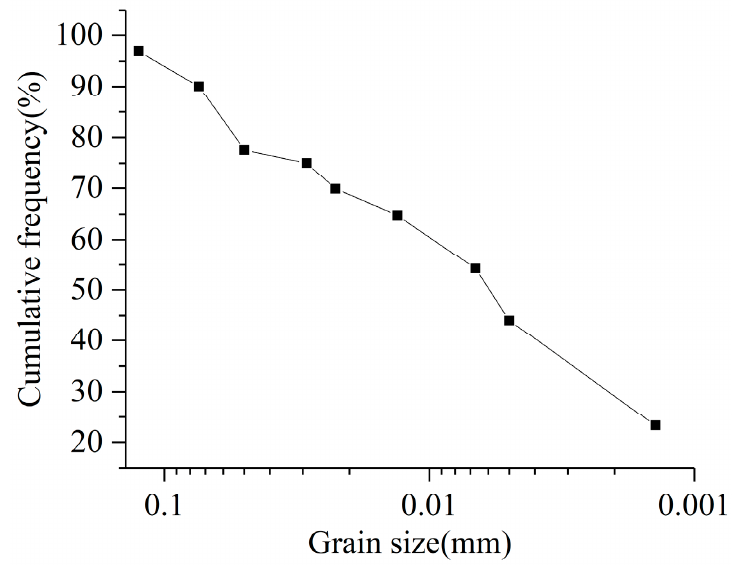
Figure 3. Particle size distribution (PSD) curve.